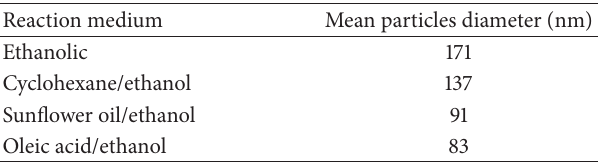
Table 1: Effects of reaction medium on mean particles diameter of curcumin loaded starch